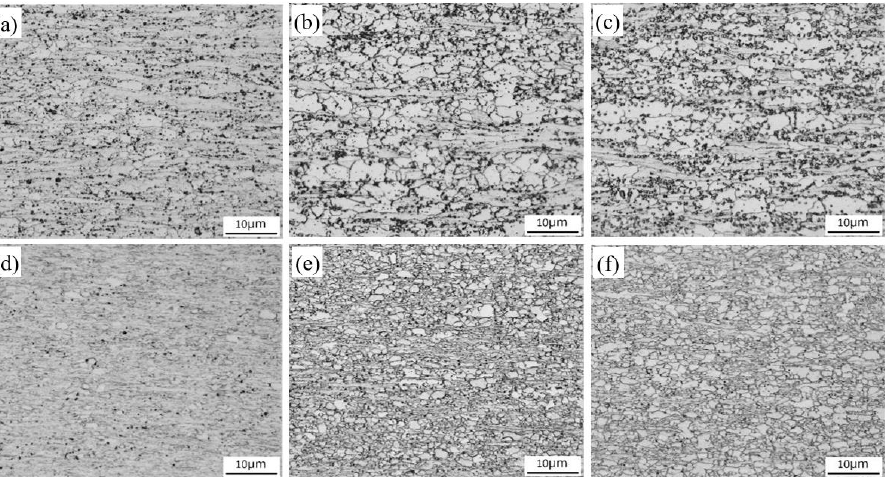
Figure 2. Microstructure of different specimens, Ti steel: ( a ) 660 °C , 300 s, ( b ) 690 °C , 200 s, ( c ) 720 °C , 200 s, Ti-V steel: ( d ) 660 °C , 1000 s, ( e ) 690 °C , 1000 s and ( f ) 720 °C , 300 s.